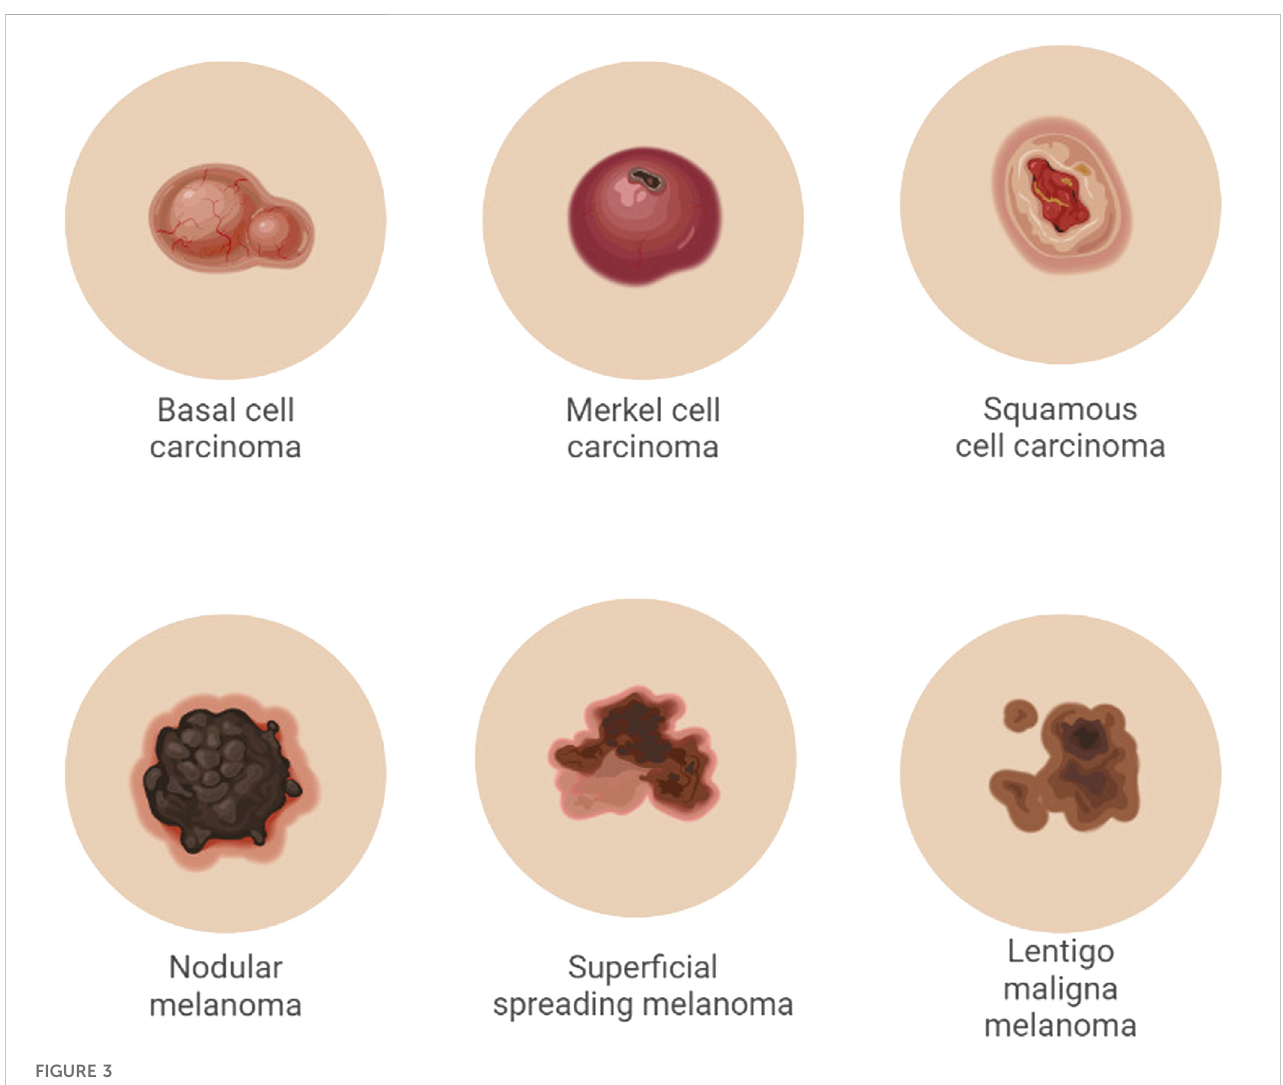
FIGURE 3 Types of